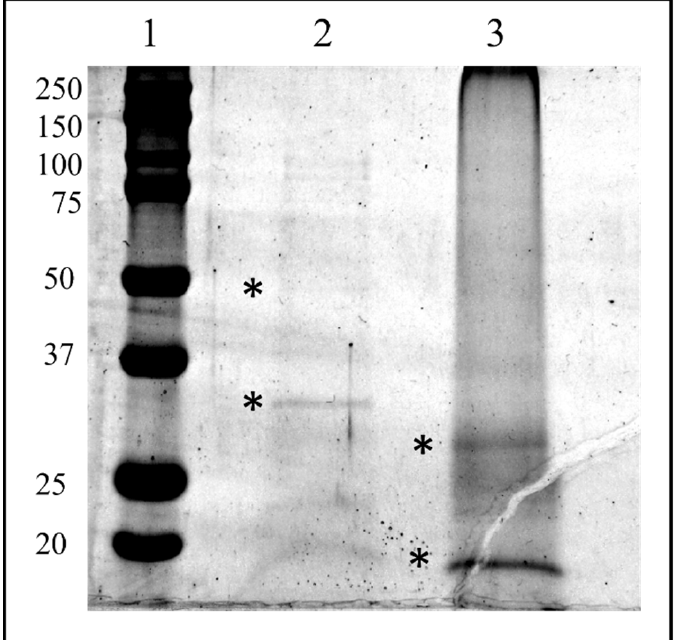
Figure 10. SDS-PAGE of biological active HPLC fraction Ovarian Proteins extracted from T. nigriceps . HPLC fraction proteins were separated on a 12.5% SDS-PAGE gel (Sigma, St. Louis, MO, USA) and stained with GelCode™ Blue Safe Protein Stain (Thermo Fisher Scientific). The bands marked with asterisks have been excised and analyzed with in situ hydrolysis digestion protocol and processed for LC/MS–MS analysis for protein identification. Lane 1: molecular weight marker (expressed in kDa) “All Blue Standards Biorad” (Biorad, Hercules, CA, USA); lane 2: proteins from HPLC fraction #22; lane 3: proteins from HPLC fraction #26.